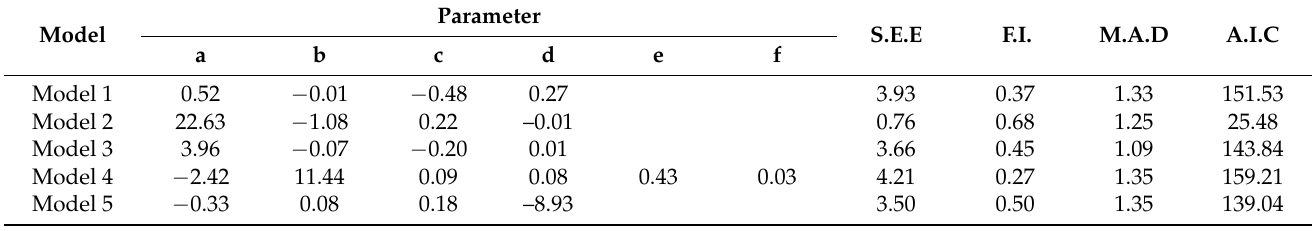
Table 5. Parameter estimates and fit statistics for mortality models in Pinus densiflora stands.